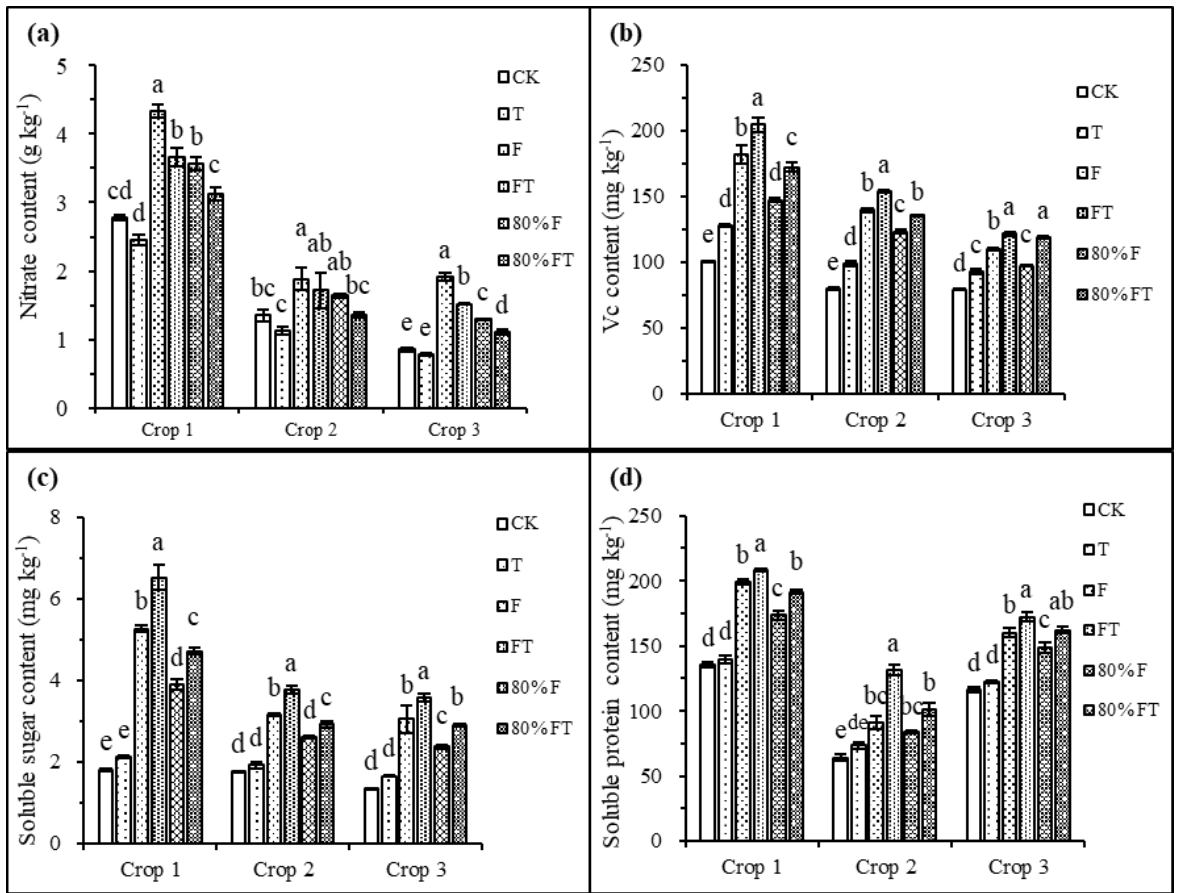
Figure 2. Effect of the preparation on pakchoi quality of nitrate content ( a ), Vc content ( b ), soluble content ( c ), and soluble protein content ( d ). Values were expressed as means (n = 4) ± SE. Different letters within the same crop indicate significance at the 5% level.